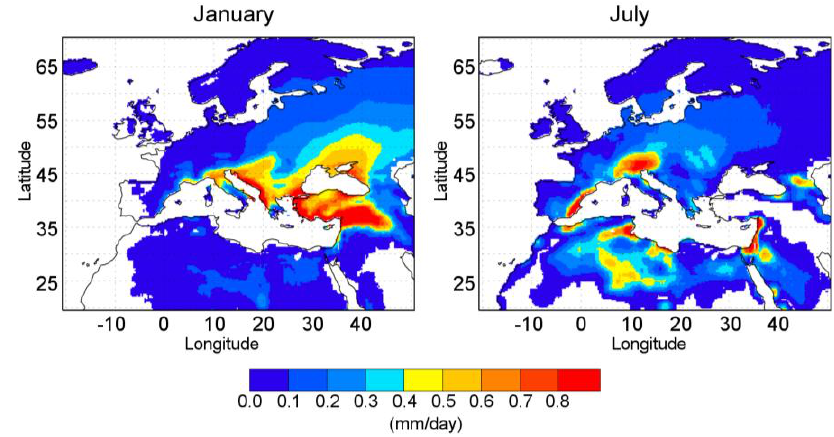
Figure 5. Monthly-averaged value of E − P < 0 integrated over ten days (PFLEX-Cli) between 1980 to 2015 obtained from the forward Lagrangian experiment for Mediterranean Sea during January (right panel) and July (left panel). Units in mm/day. White areas over continent are regions not influenced by the Mediterranean moisture.